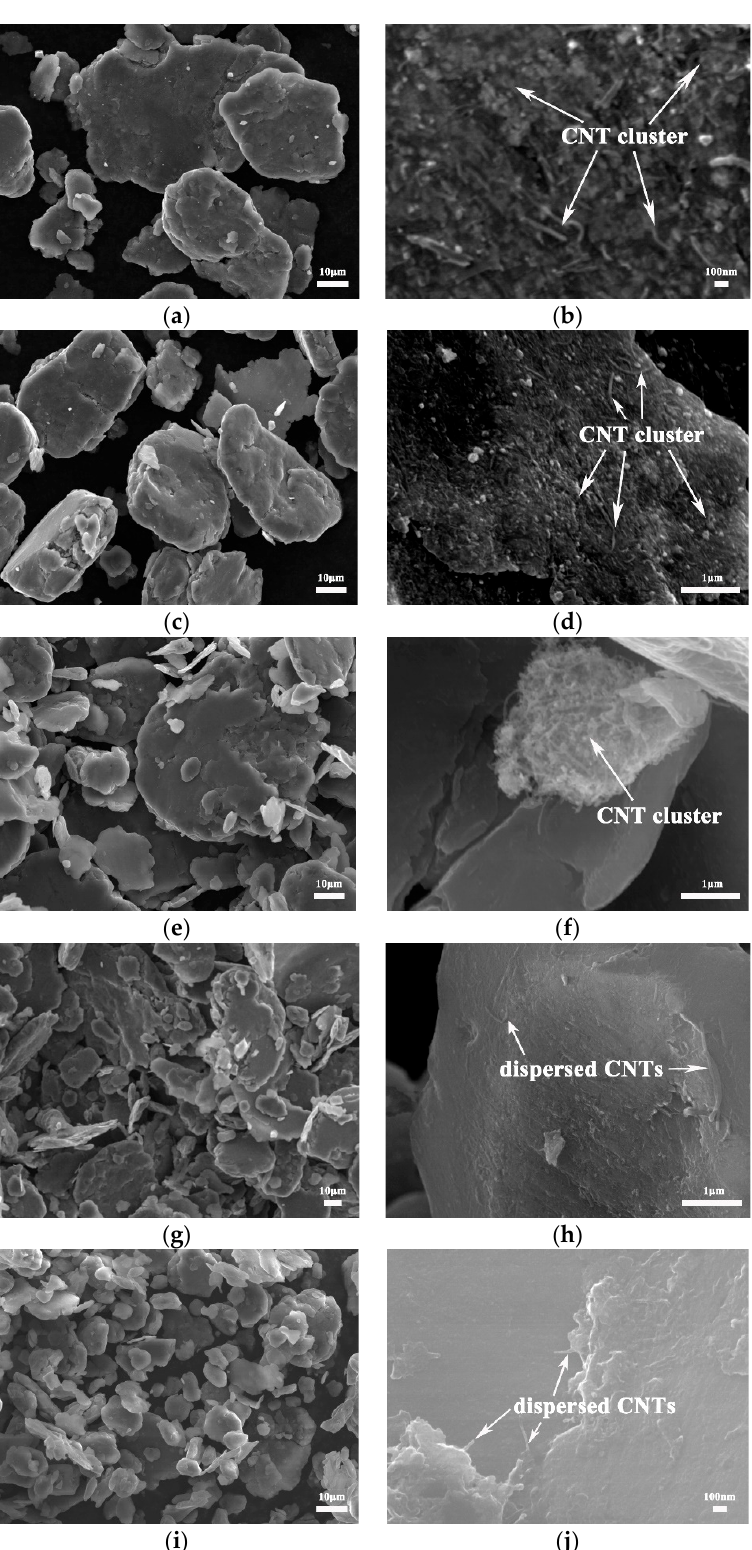
Figure 3. SEM morphology of CNTs/Mg powders with magnesium powders grinded for different times. ( a , b ) as-received, ( c , d ) 15 h, ( e , f ) 30 h, ( g , h ) 45 h and ( i , j ) 60